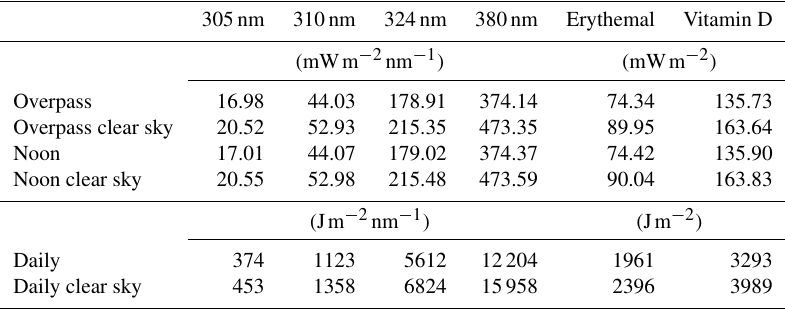
Figure 4. The reflectance at 354nm (a) , the cloud optical depth (b) , and the UV index at solar noon (c) of the TROPOMI UV algorithm based on OMI test data for 13 August 2007. Jokioinen (south-western Finland) and Sodankylä (northern Finland) are marked with black squares. Table 3. TROPOMI UV output for Sodankylä 13 August